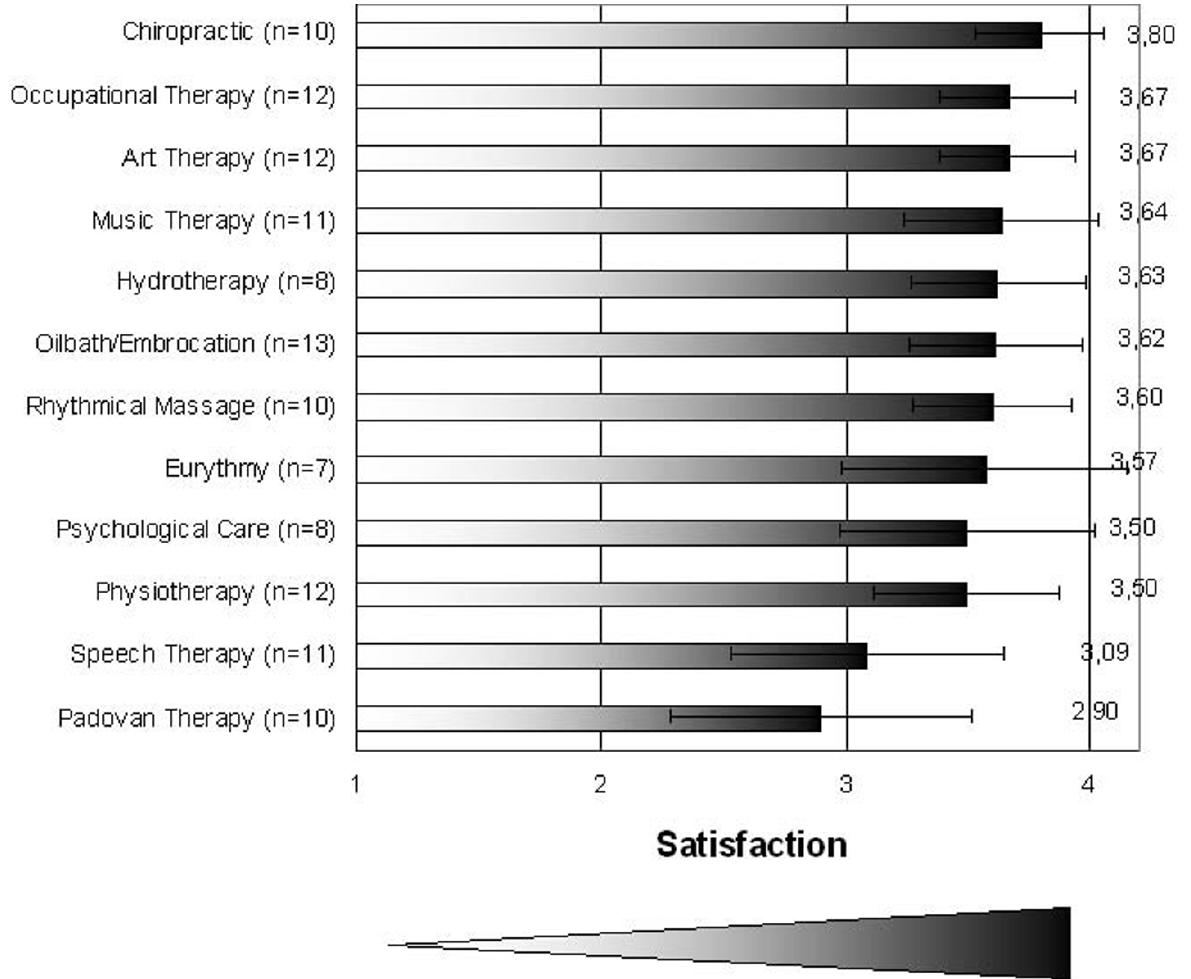
Figure 2 Satisfaction of patient ’ s relatives with therapies (Mean and 95% Confidence Interval) from 1 = very unsatisfied to 4 = very satisfied sorted by level of satisfaction